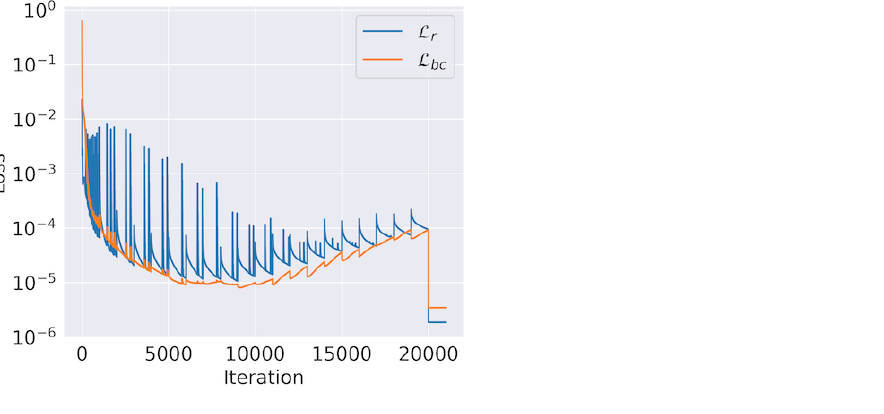
Figure 10. cSPINNs’ training loss for High Dimensional Poisson equation. (with ResNet block- enhanced modified neural network) Table 3. The relative computational cost of solving different PDEs with cSPINNs and PINNs.